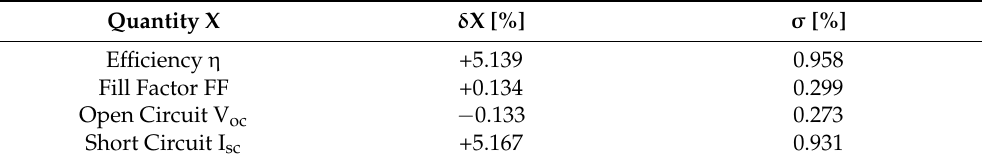
Table 5. Arithmetic means of the relative change δ X in different quantities X after vacuum exposure: power conversion efficiency η , fill factor FF, open circuit voltage V oc and short circuit current I sc ; Six PTS submodules were investigated; quantities measured at 20 ◦ C; standard deviation σ